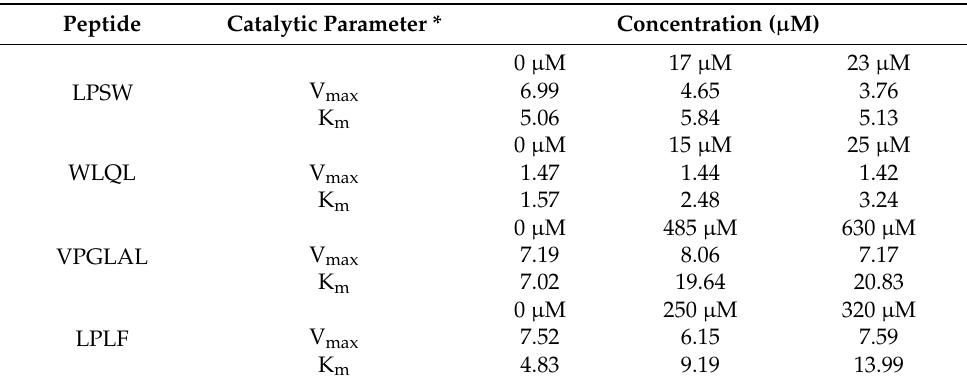
Table 2. Kinetic constants of enzyme-catalyzed reactions at different peptide concentrations. Peptide Catalytic Parameter * Concentration ( µ M)